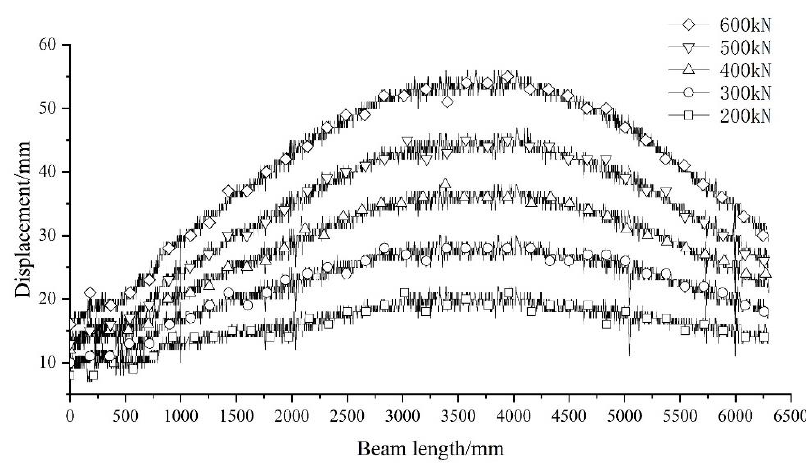
Figure 14. Load-displacement curves under various load grades.